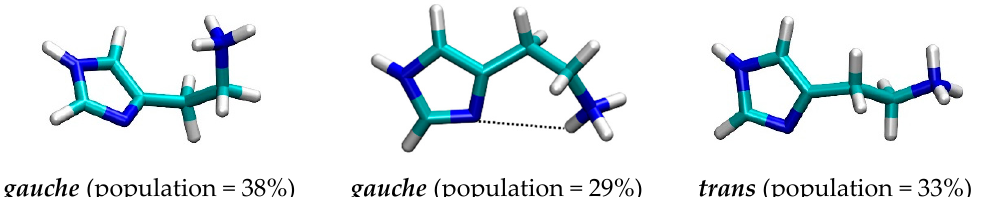
Figure 6. Representative conformations along with their populations of the histamine monocation at the H 2 receptor binding site as revealed by molecular dynamics simulation.